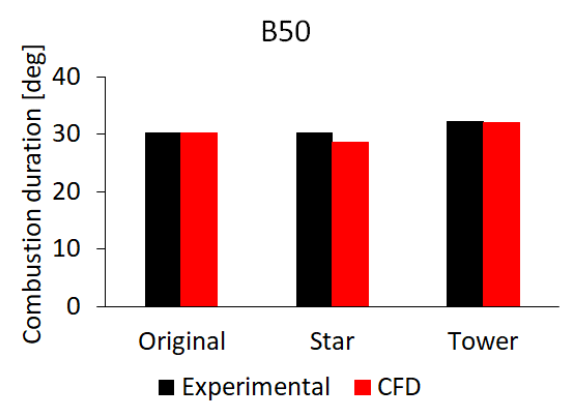
Figure 12. Comparison between the computed and experimental combustion durations for the B50 operating point and the three different piston